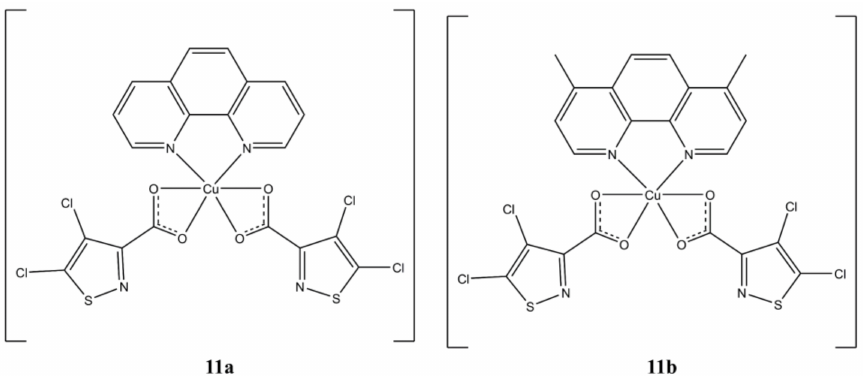
Figure 11. Structures of [Cu(phen)(4,5-dCl-ICA) 2 ] ( a ) and [Cu(4,7-diMephen)(4,5-dCl-ICA) 2 ] ( b